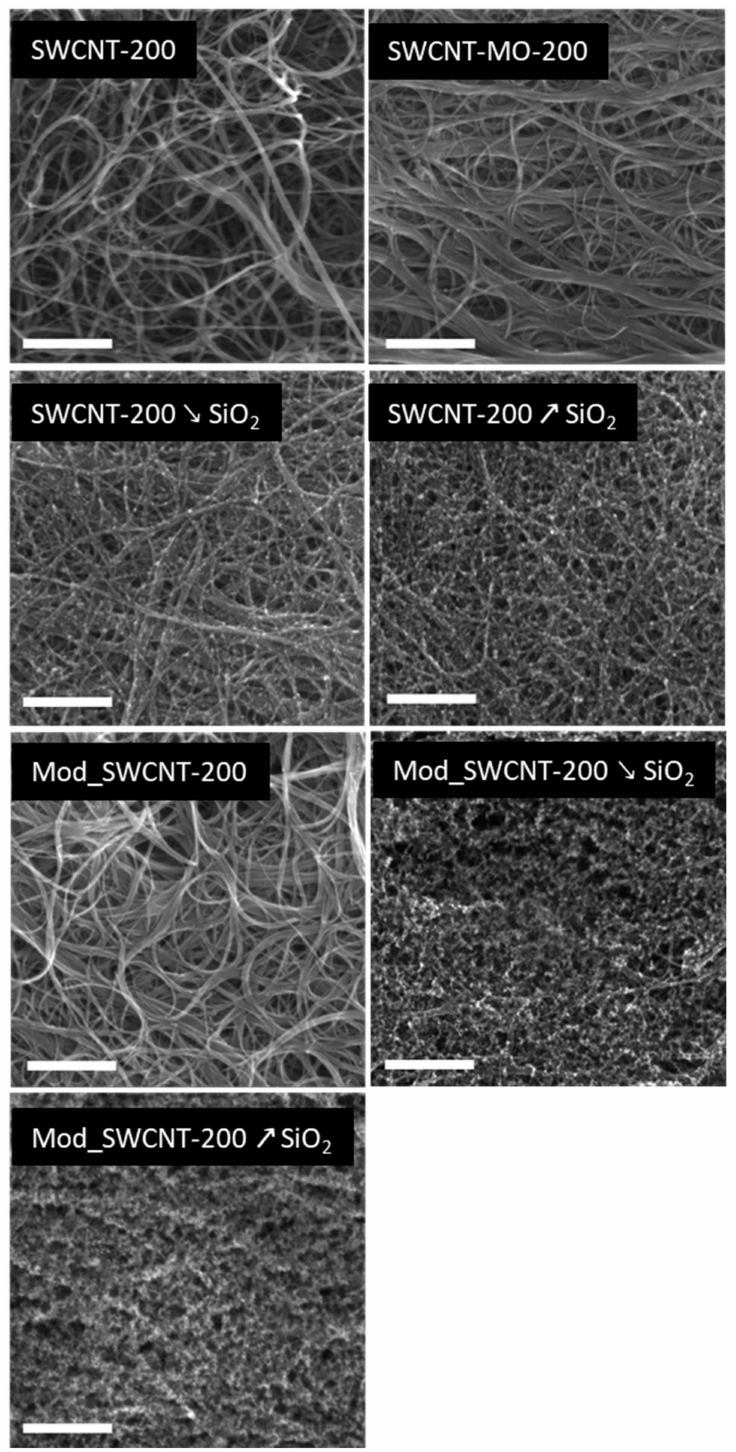
Figure 4. SEM images of the membrane surfaces. Scale bar corresponds to 500 nm. The membranes modified with SiO 2 nanoparticles (SWCNT-200 (cid:38) SiO 2 and SWCNT- 200 (cid:37) SiO 2 ) clearly show small particles of SiO 2 deposited on the surface of the CNTs. The membrane SWCNT-200 (cid:37) SiO 2 exhibits a structure with a significantly higher amount of SiO 2 nanoparticles, which is in good agreement with the elemental composition obtained by EDS (Table 6). The purpose of SiO 2 nanoparticle synthesis on the surface of the